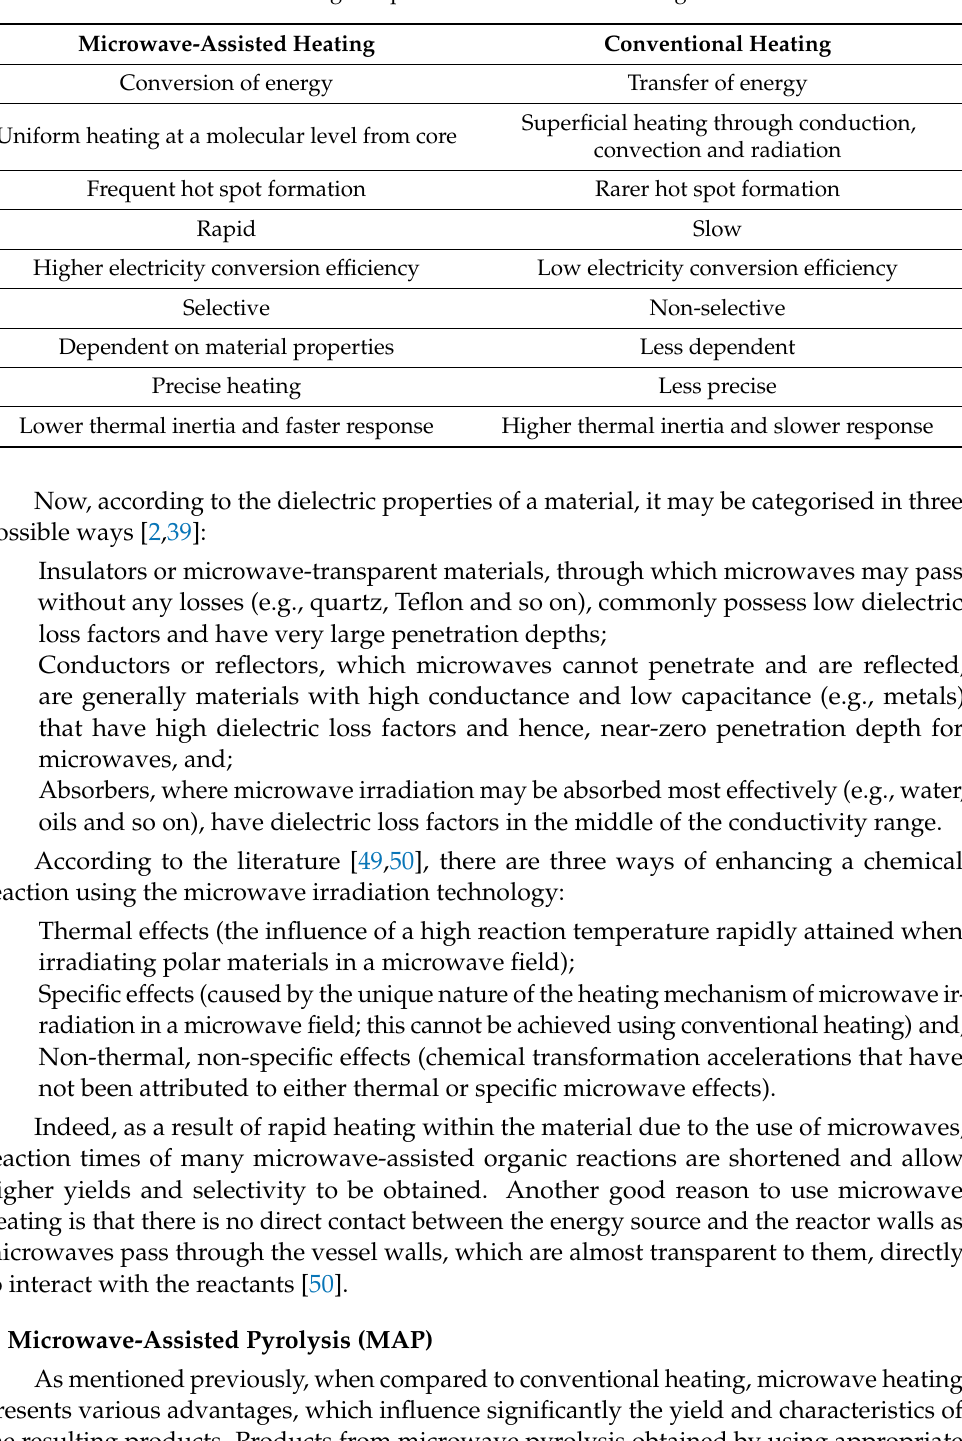
Table 5. Microwave-assisted heating compared to conventional